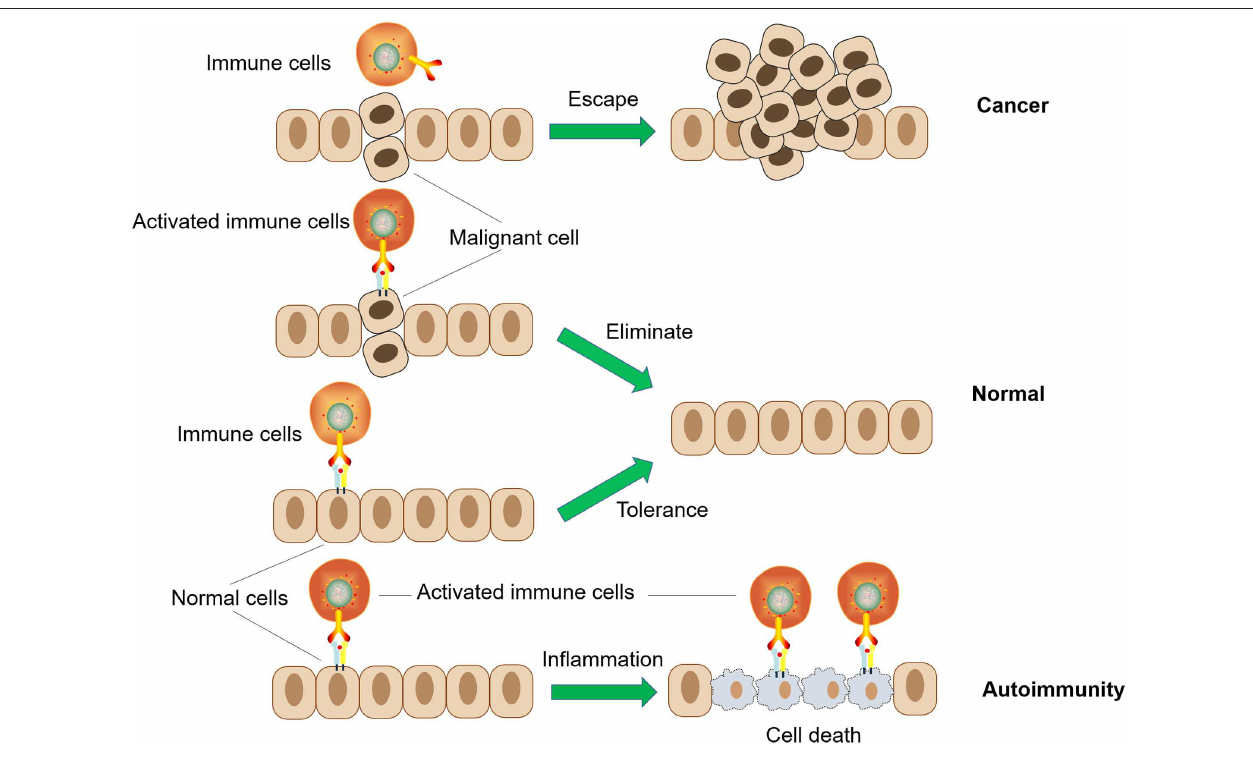
FIGURE 2 | Two types of immune dysfunction: cancer and